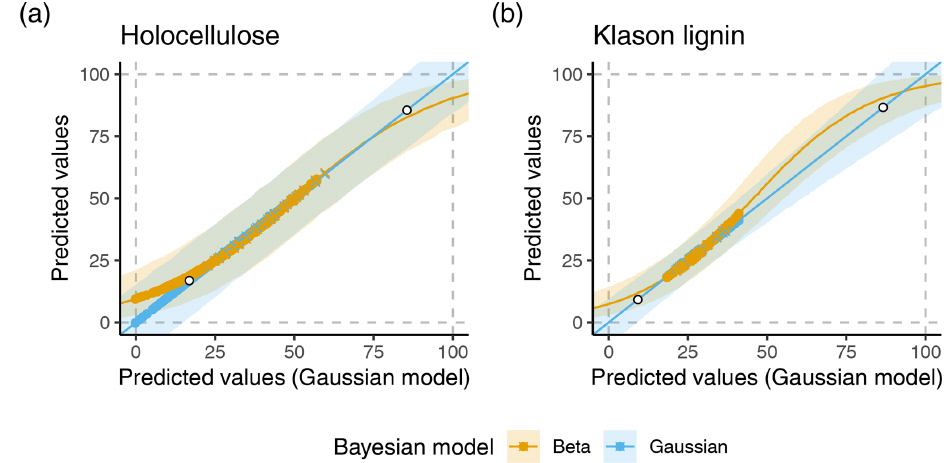
Figure 2. Predicted holocellulose (a) and Klason lignin (b) contents using either the original Gaussian models or a beta regression model, versus predictions of the original Gaussian model covering the entire interval [0, 100] mass-%. Colored lines within shaded regions are median predictions. Shaded areas and boundaries are 90% prediction intervals. Colored points are median point predictions for the peat (round points) and vegetation (crosses) samples from Hodgkins et al. (2018). Colors differentiate predictions of the original Gaussian model (blue) and the model with beta distribution (yellow). White filled points indicate the fitted values for which the 90% prediction interval of the Gaussian model contains unrealistic